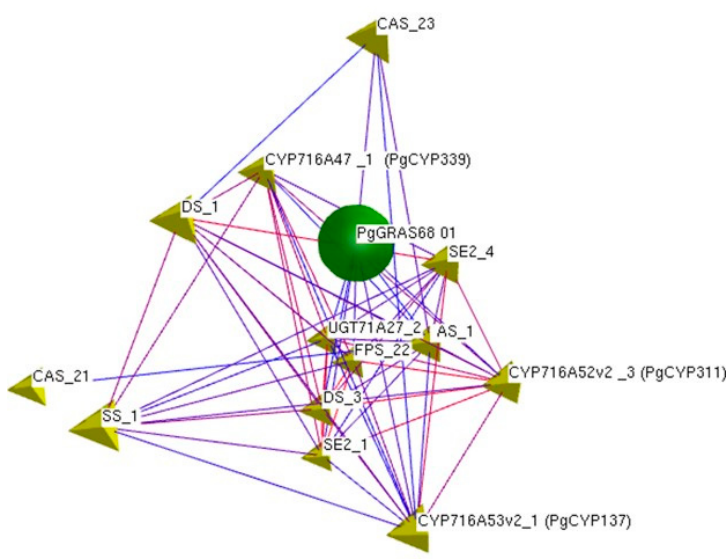
Figure 3. Network interaction between PgGRAS68-01 gene and key enzyme genes of ginsenoside biosynthesis. The green ball is PgGRAS68-01 gene, the yellow triangle is key enzyme gene.